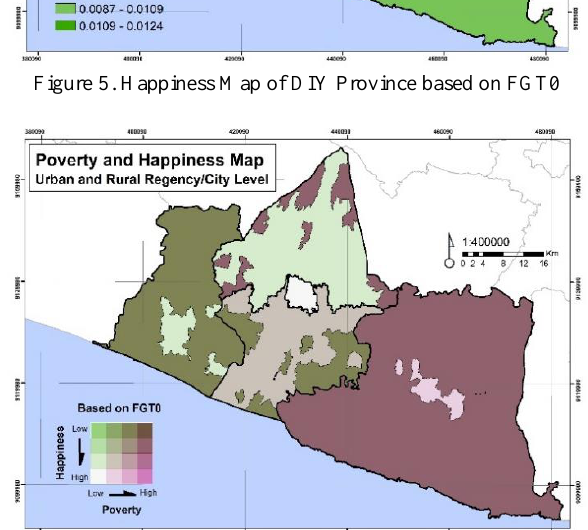
Figure 6. Poverty and Happiness Map of DIY Province based